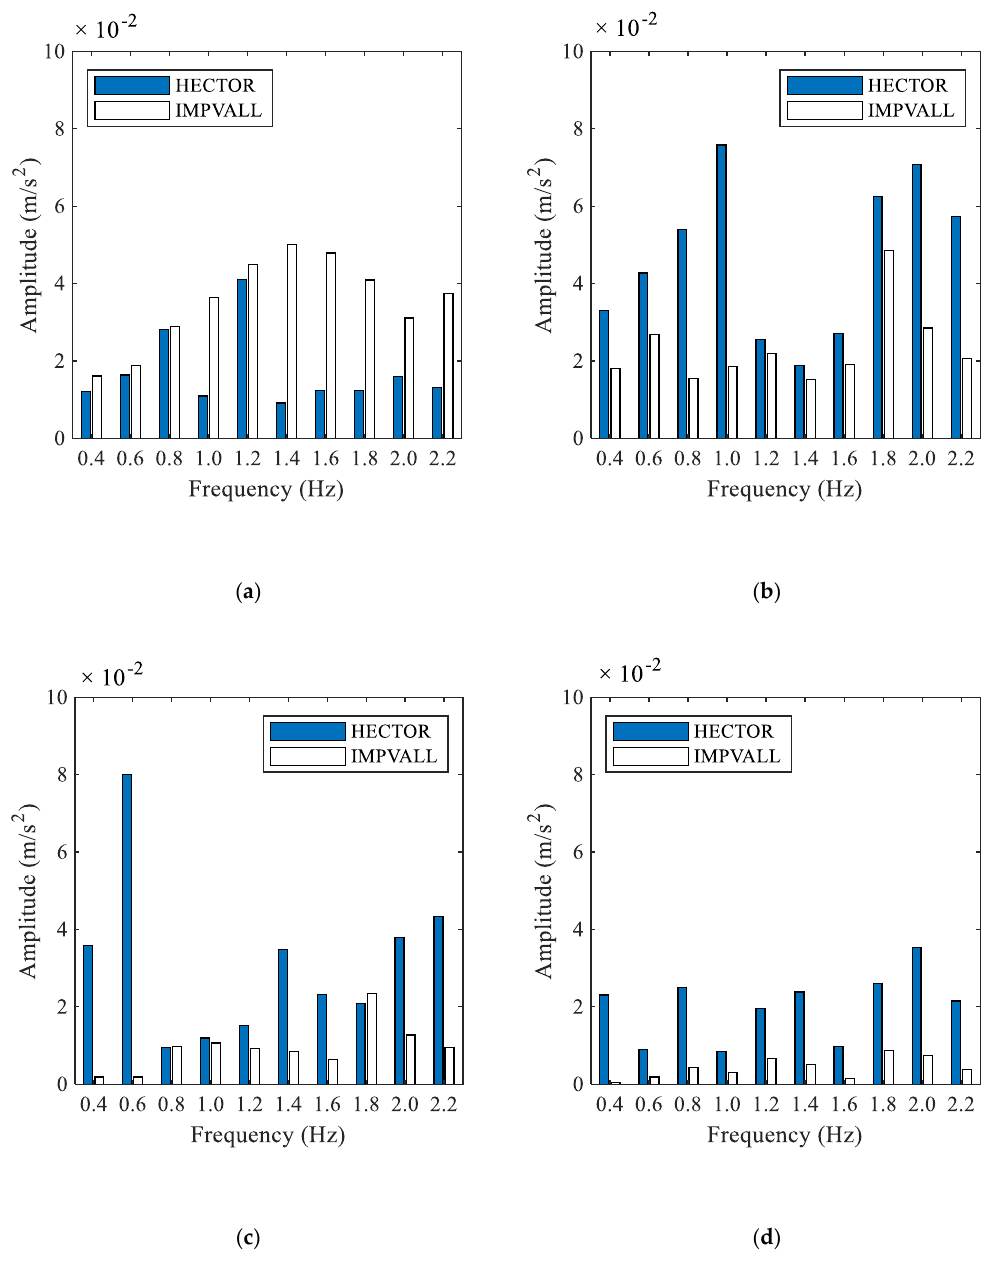
Figure 5. Forty feature values of ground motions: ( a ) Features of 0~5 s time interval; ( b ) features of 5~10 s time interval; ( c ) features of 10~15 s time interval; ( d ) features of 15~20 s time